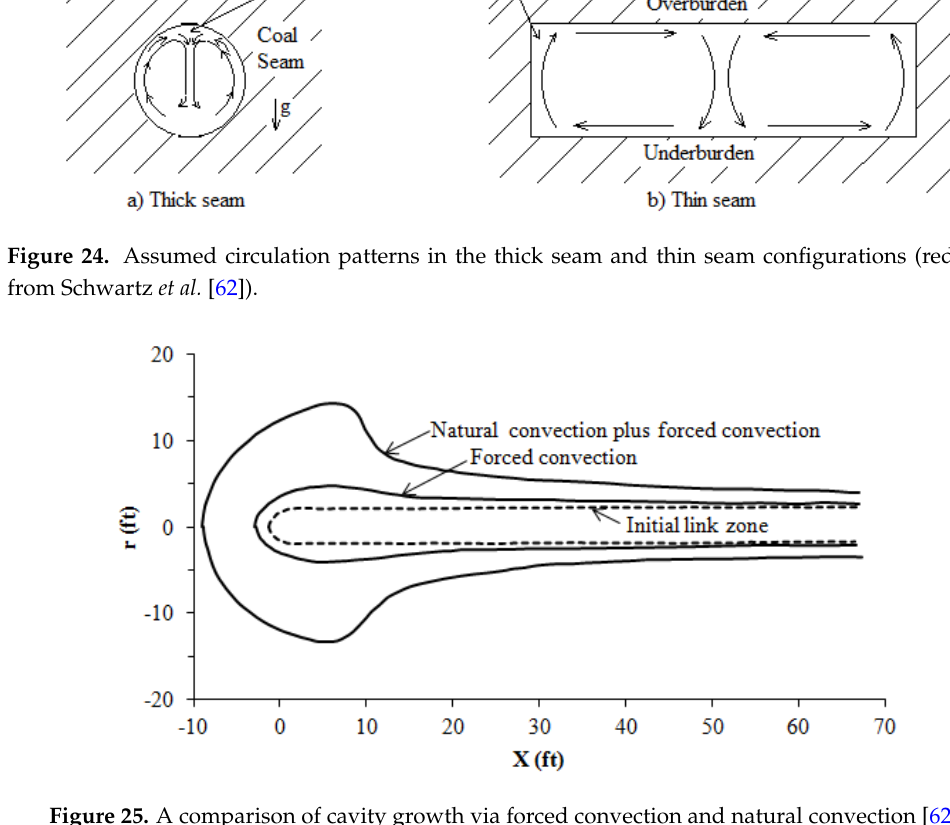
Figure 25. A comparison of cavity growth via forced convection and natural convection [62].